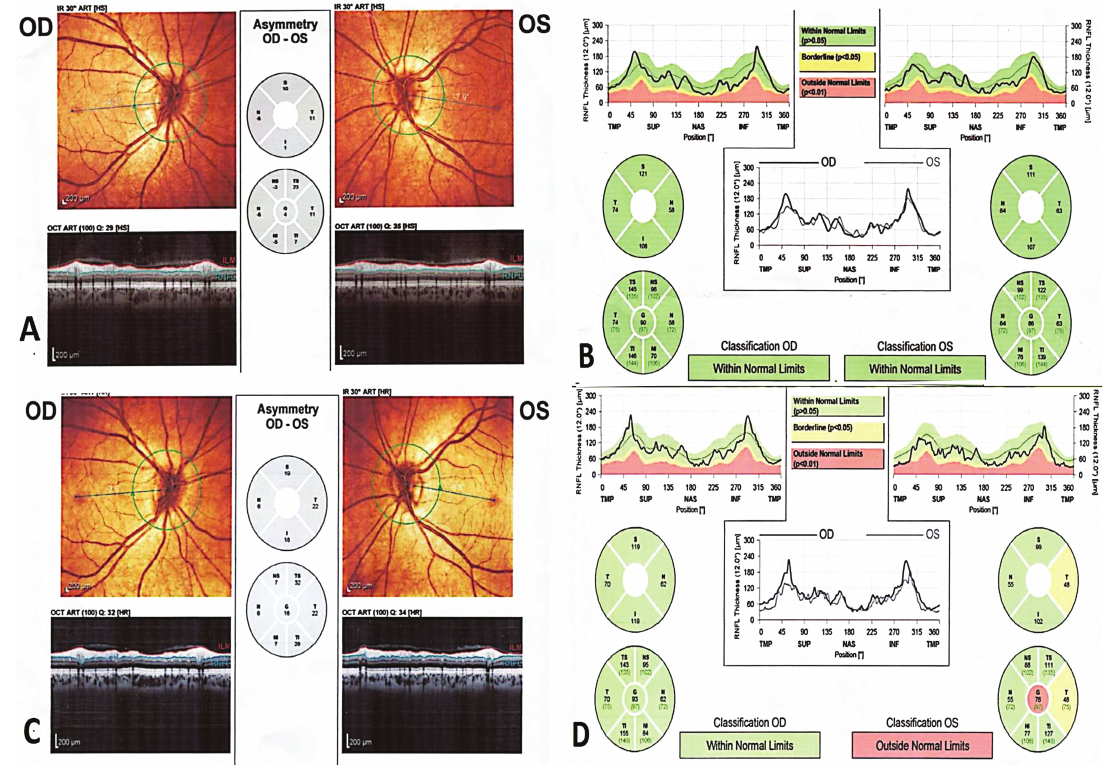
Figure 3. Peripapillary optical coherence tomography; at presentation, the optic nerve head images (A), and retinal nerve fiber layer thickness maps (B) were normal in both eyes. Three months after presentation, the optic nerve head image showed mild temporal pallor in the left eye (C), and retinal nerve fiber layer thickness maps demonstrated a reduction in the temporal retinal nerve fiber layer thickness of the left eye (D).